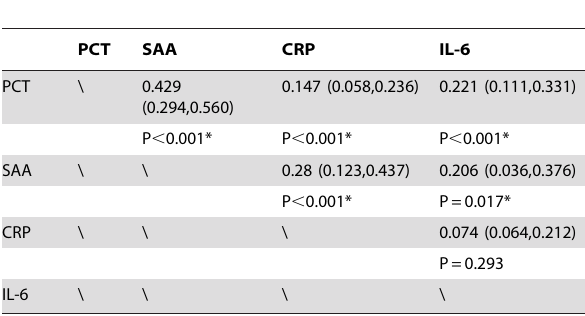
Results are presented as mean area difference (95% confidence interval) between two indicators. *=P , 0.05 according to the Mann-Whitney U Test. PCT=procalcitonin; SAA=serum amyloid A; CRP= C-reactive protein; IL- 6=interleukin-6.